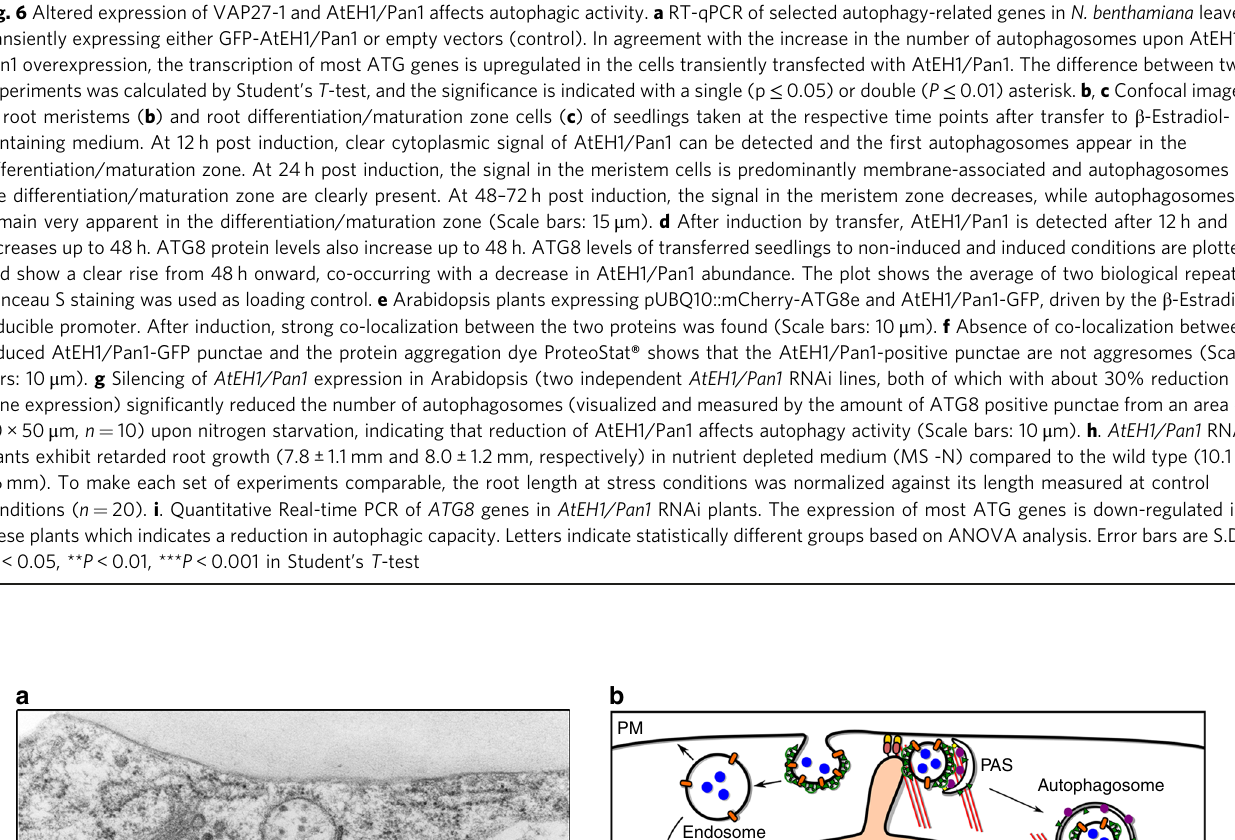
Fig. 7 Model for AtEH/Pan1 regulated autophagy at the ER-PM contact sites. a A representative TEM image showing the formation of autophagosomes at the ER-PM contact sites (Scale bar: 500 nm). b Model for autophagosome formation regulated by AtEH/Pan1 and the endocytic machinery at the EPCS. Endocytosis occurs at the ER-PM contact sites through the endocytic machinery that involves the TPLATE complex, AP-2 and clathrin. Endocytosed material can traf fi c through the conventional pathway, which can either recycle the membrane proteins back to the PM (early endosome) or deliver them to the vacuole (late endosome). In addition, endocytosed material can also be integrated in autophagosomes at the ER-PM contact sites, through the interaction between VAP27-1 and AtEH/Pan1. Internalization by endocytosis is likely shared between the conventional retrograde traf fi cking and the autophagosomal degradation pathways. Therefore, conditions affecting endocytosis, will also to some extent affect this autophagosomal pathway. Our data are in agreement with a dual function for AtEH/Pan1 proteins. On the one hand, co-localization with ATG6 and interaction with the actin cytoskeleton hints for a role in early autophagosome biogenesis. The presence of AtEH/Pan1 at the PAS (pre-autophagosomal structure) is derived from the co-localization with ATG6. On the other hand, vacuolar delivery and their endocytic role argue for a function in cargo selection for